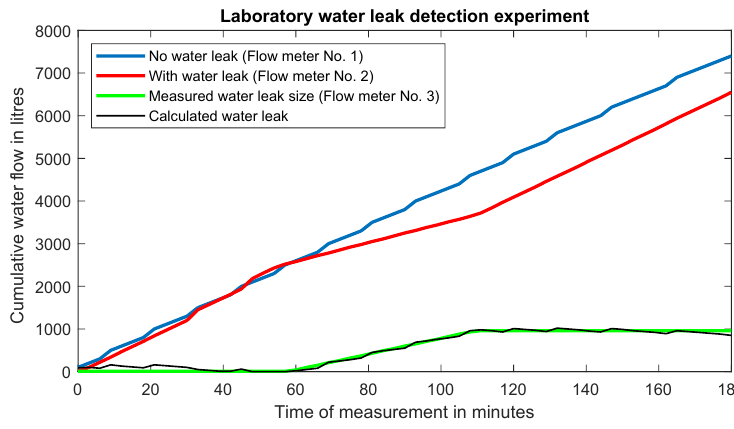
Figure 10. Water leak detection experiment.